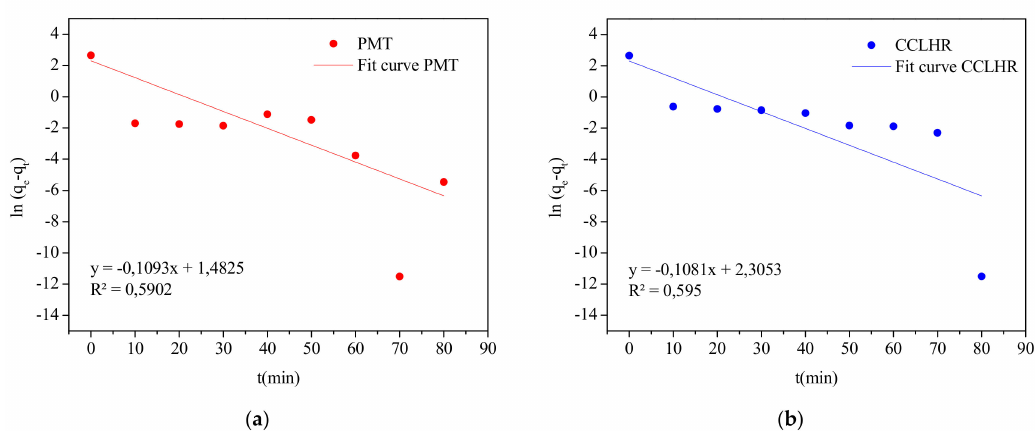
Figure 11. Plots of pseudo-first-order kinetic model for the biosorption: ( a ) PMT and ( b ) CCLHR.